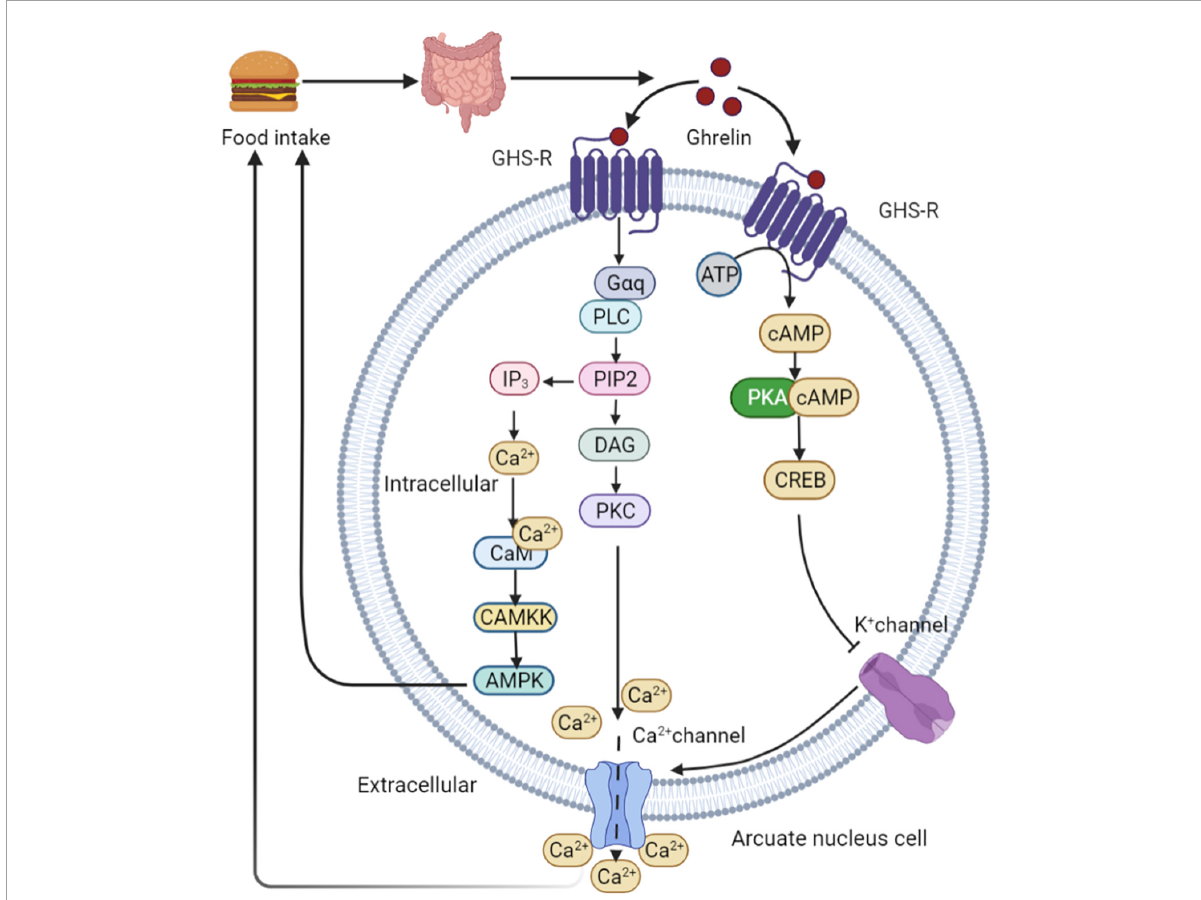
FIGURE5 Ghrelin mediated appetite regulation. PKA is activated by ghrelin in a cAMP-dependent manner. PKA phosphorylates CREB, thereby inhibiting potassium channels, depolarizing cells, and opening N-type calcium channels. Ca 2 + are then released from intracellular storage, indicating ghrelin-mediated appetite regulation. High calcium levels induce a second cascade of reactions involving PLC, which triggers the hydrolysis of PIP2 in the cell membrane. This process leads to increased intracellular calcium levels in two ways. First, PIP2 activates DAG for PKC activation through tyrosine phosphorylation, resulting in the opening of L-type calcium channels. Second, IP3 activated by PIP2 induces the rapid release of calcium from the endoplasmic reticulum. Increased intracellular Ca 2 + levels interact with CAM to activate CAMKK, an upstream kinase that activates AMPK and stimulates appetite. GHS-R, growth hormone secretagogue receptor; PLC, phospholipase C; PIP2, phosphatidylinositol-4,5-diphosphate; DAG, diacylglycerol; PKC, protein kinase C; IP3, inositol triphosphate; CAM,